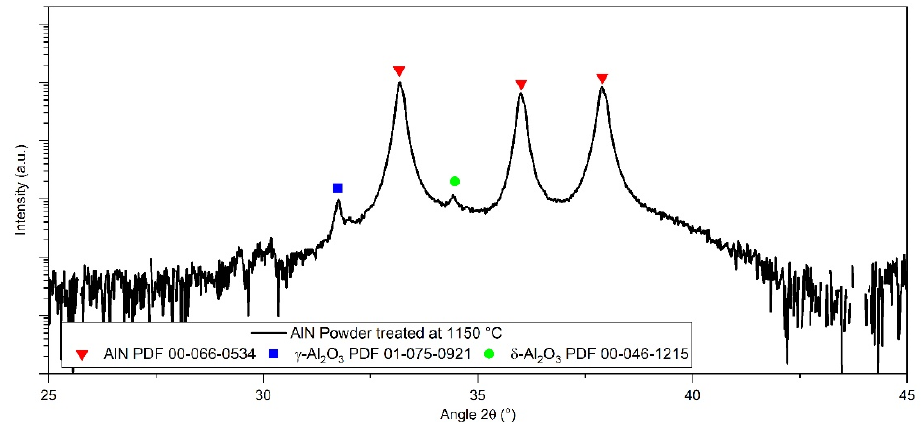
Figure 6. Selected area of AlN treated at 1150 °C diffraction pattern.